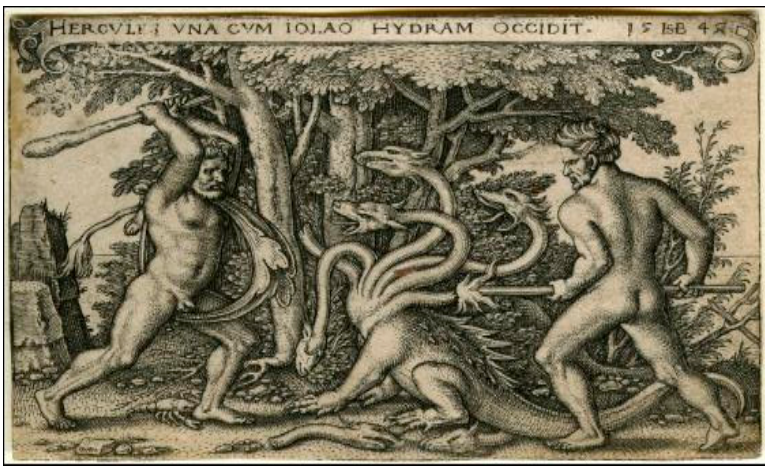
Figure 2. Depiction of the ancient Greek/Roman divine hero, Heracles, and his nephew (Iolaus) fighting the Hydra of Lerna, a serpentine water monster with heads that regenerated stronger and more numerous if severed [142].